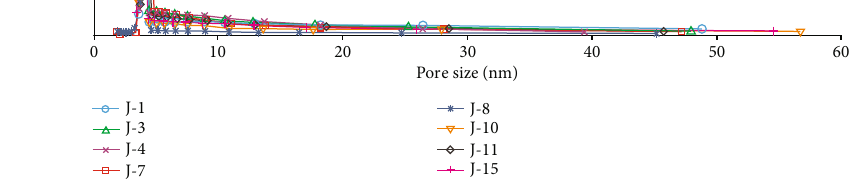
Figure 3: Pore size distribution characteristics of Longtan shales.